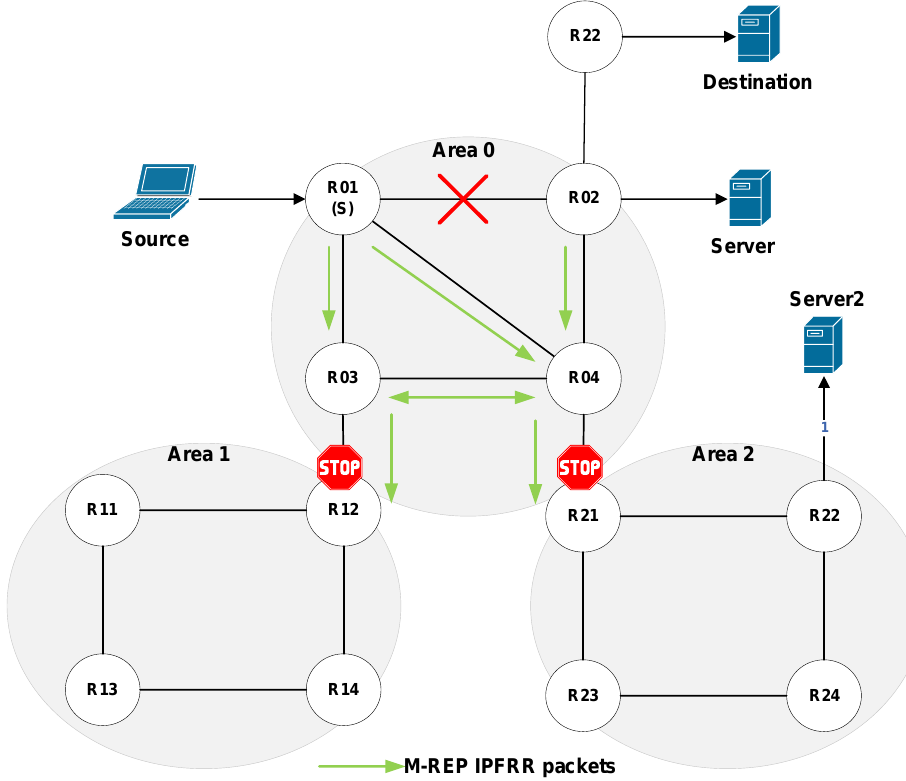
Figure 11. The flooding process with modified ABR.